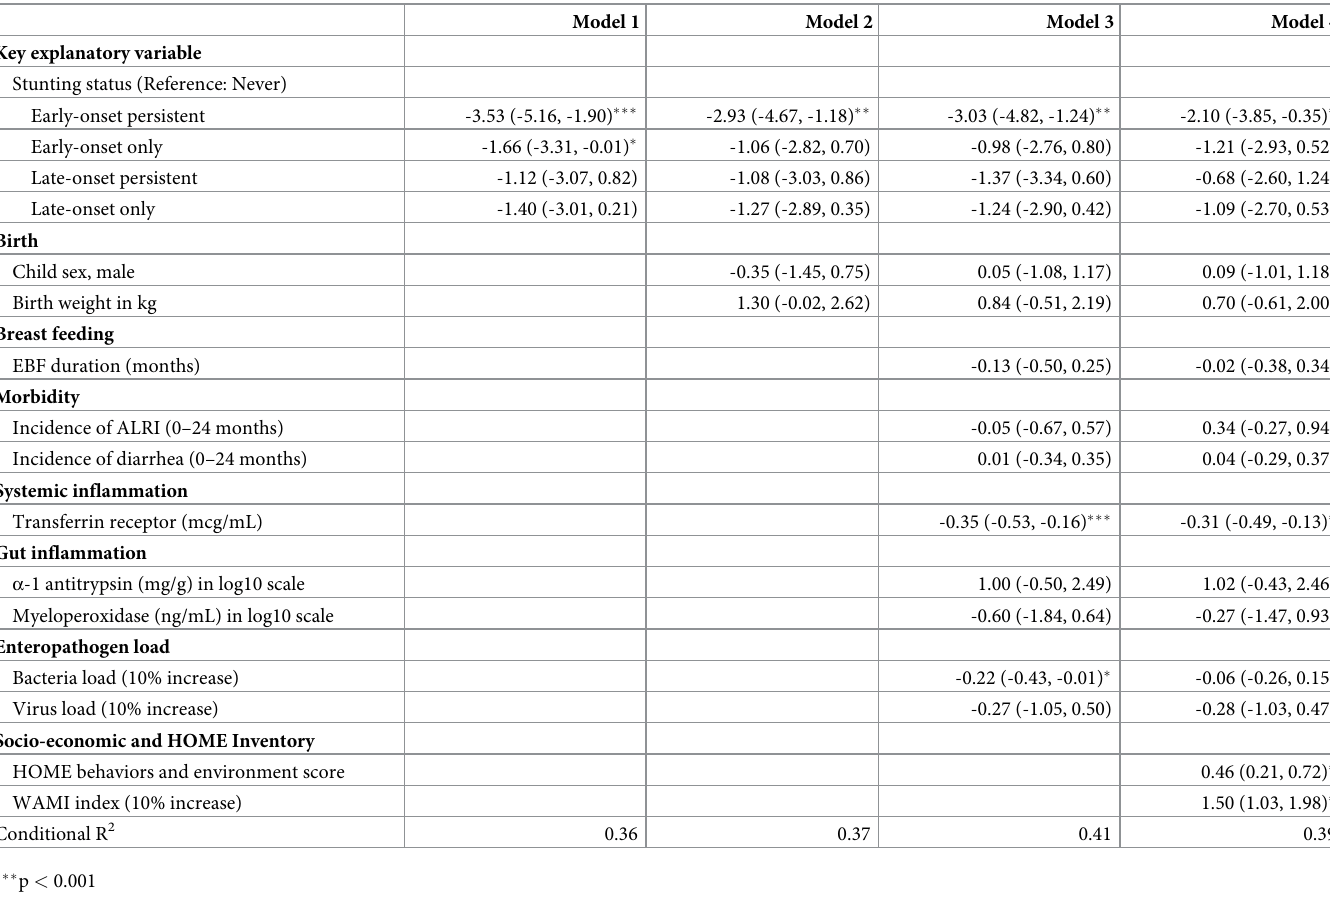
Table 2. Multivariate mixed effect linear regression model results of factors associated with WPPSI t-scores at five years of age at six sites in the MAL-ED study.